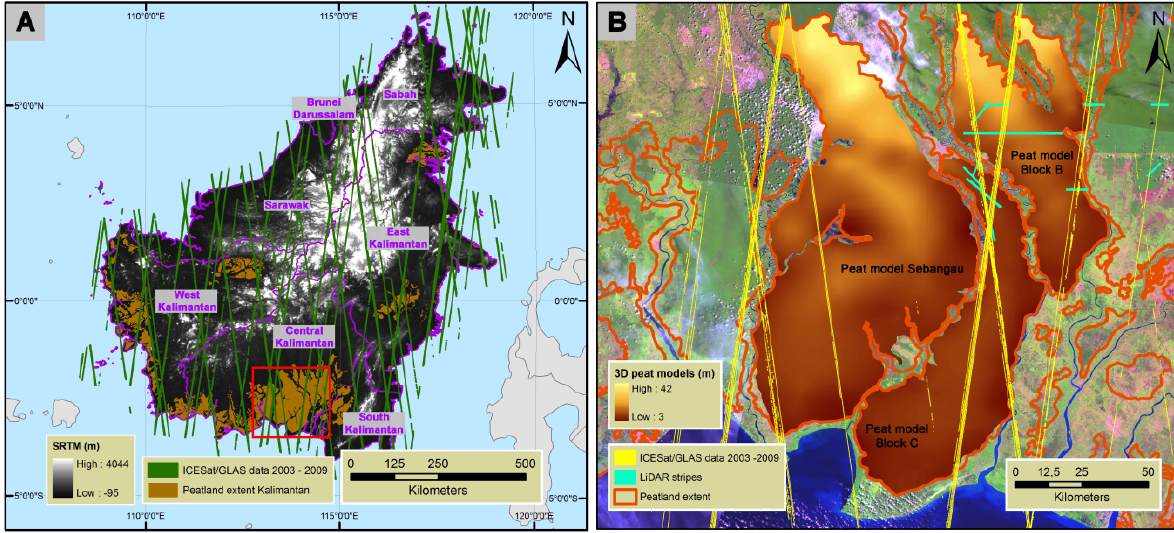
Figure 1. Overview of the study area: (A) : The island of Borneo and the peatland extent within Kalimantan, Indonesia, derived from maps prepared by Wetland International [32]. Shown are the ICESat/GLAS transects from the years 2003 to 2009, which were used in this study (shots with incorrect elevation flags were filtered out), superimposed on Shuttle Radar Topography Mission (SRTM) data; (B) : Location of the investigated 3D peat models and the LiDAR stripes intersecting ICESat/GLAS data within Central Kalimantan superimposed on Landsat TM and ETM+ data (bands 5, 4, 3). Peatland extent (orange outline) and the examined ICESat/GLAS data from the years 2003 to 2009 are also indicated. The red rectangle in (A) shows the location and extent of